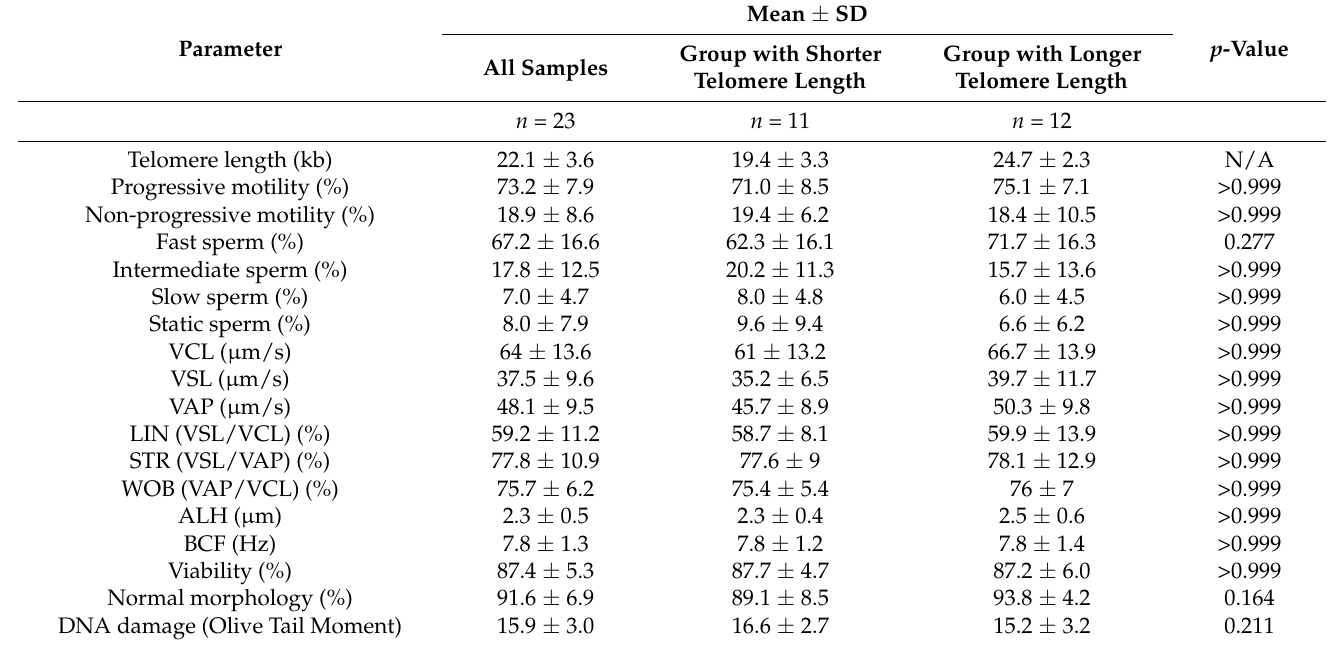
picted in Table 2. No correlation between sperm telomere length and viability, morphology, or DNA damage was observed ( p >